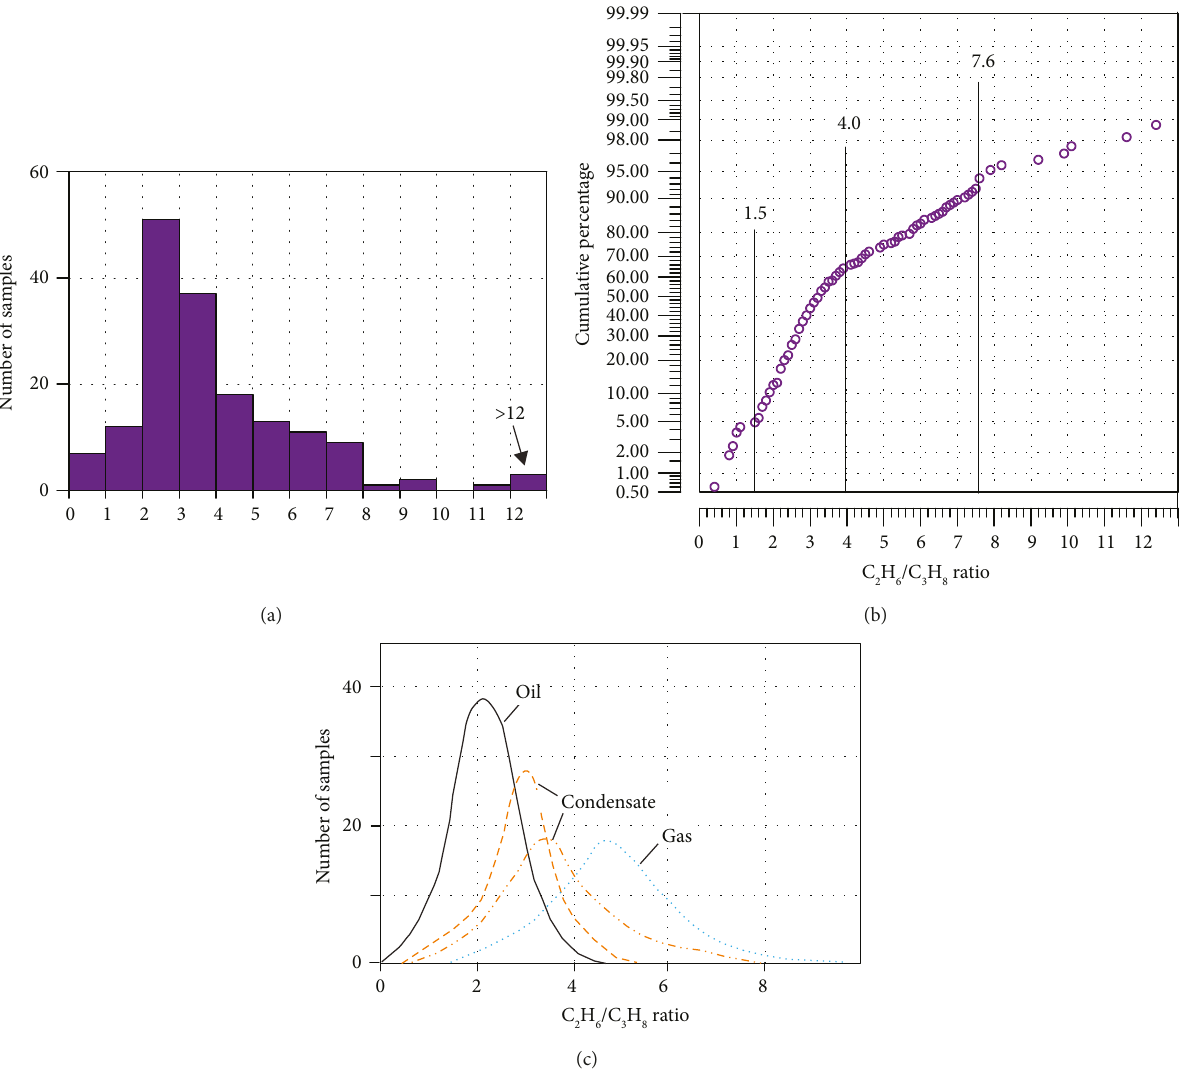
Figure 5: Histogram (a) and cumulative frequency diagram (b) of the C ratios in world hydrocarbon reservoirs (c) (after